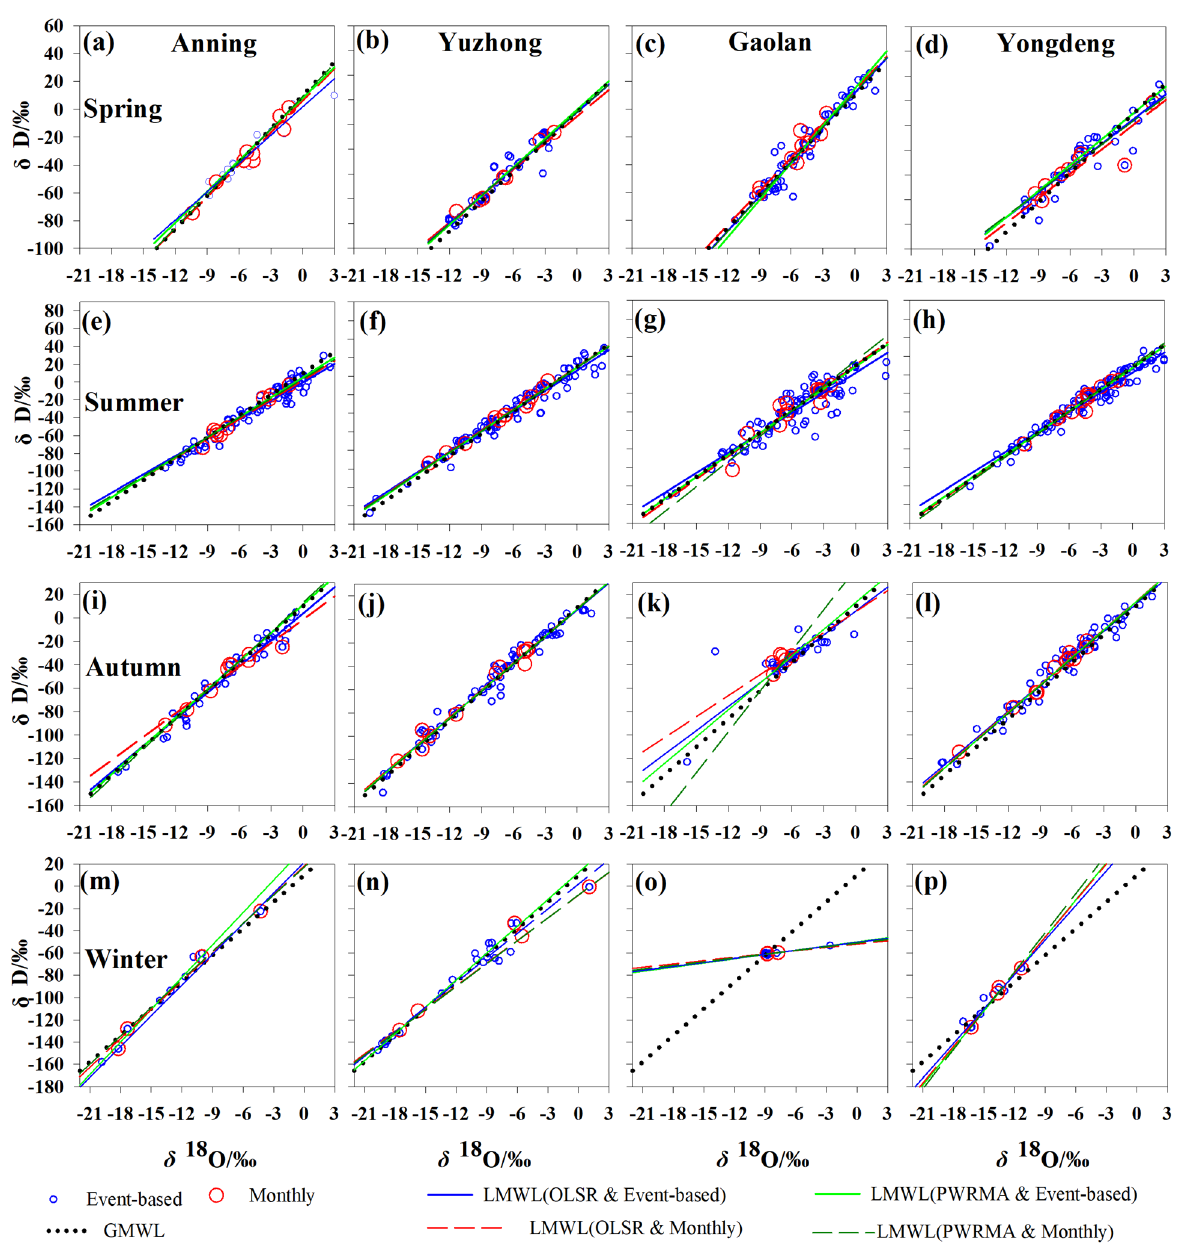
Figure 5. Linear relationship between δ D and δ 18 O using event-based and monthly data on a seasonal basis for each sampling station in Lanzhou from 2011 to 2014.